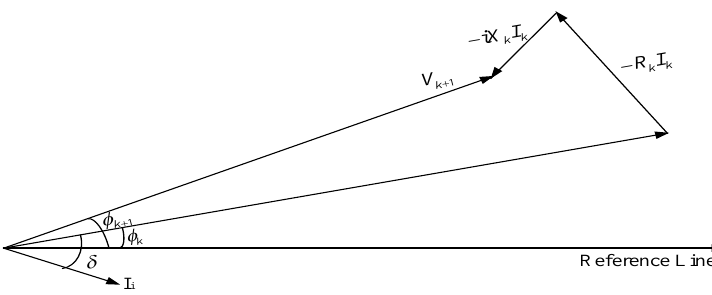
Figure 4. Voltage and current phasor representation of the system without DSTATCOM.